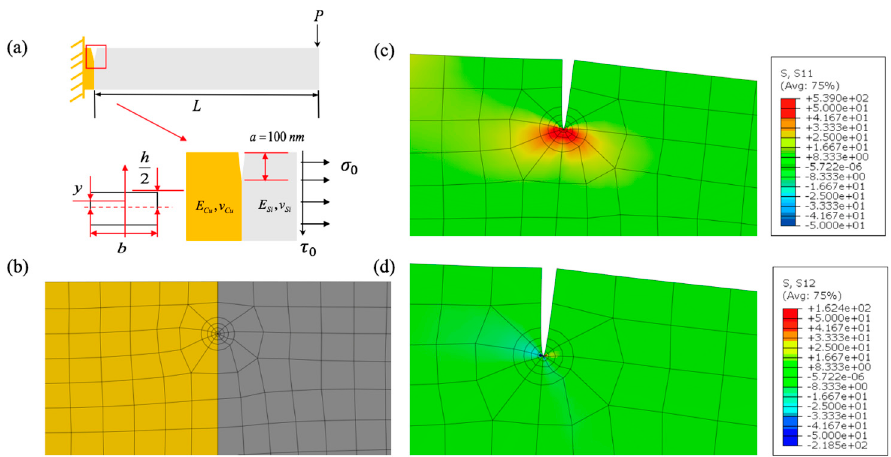
Figure 6. ( a ) SEM images of post-failure of cantilever beam, ( b ) top view details, ( c ) interfacial details (element analysis conducted within the red-boxed region).